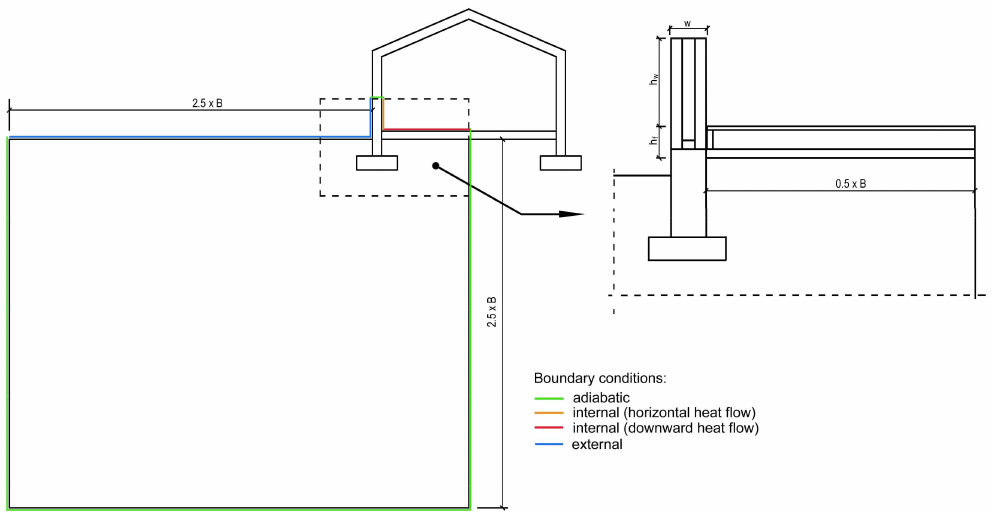
Figure 6. Dimensions of the partitions used in Equation (1): w = 0.39 or 0.44 m, h w = 3 · w = 1.17 or 1.32 m, h f = 0.34 m, B = 8.00 m (recommended by